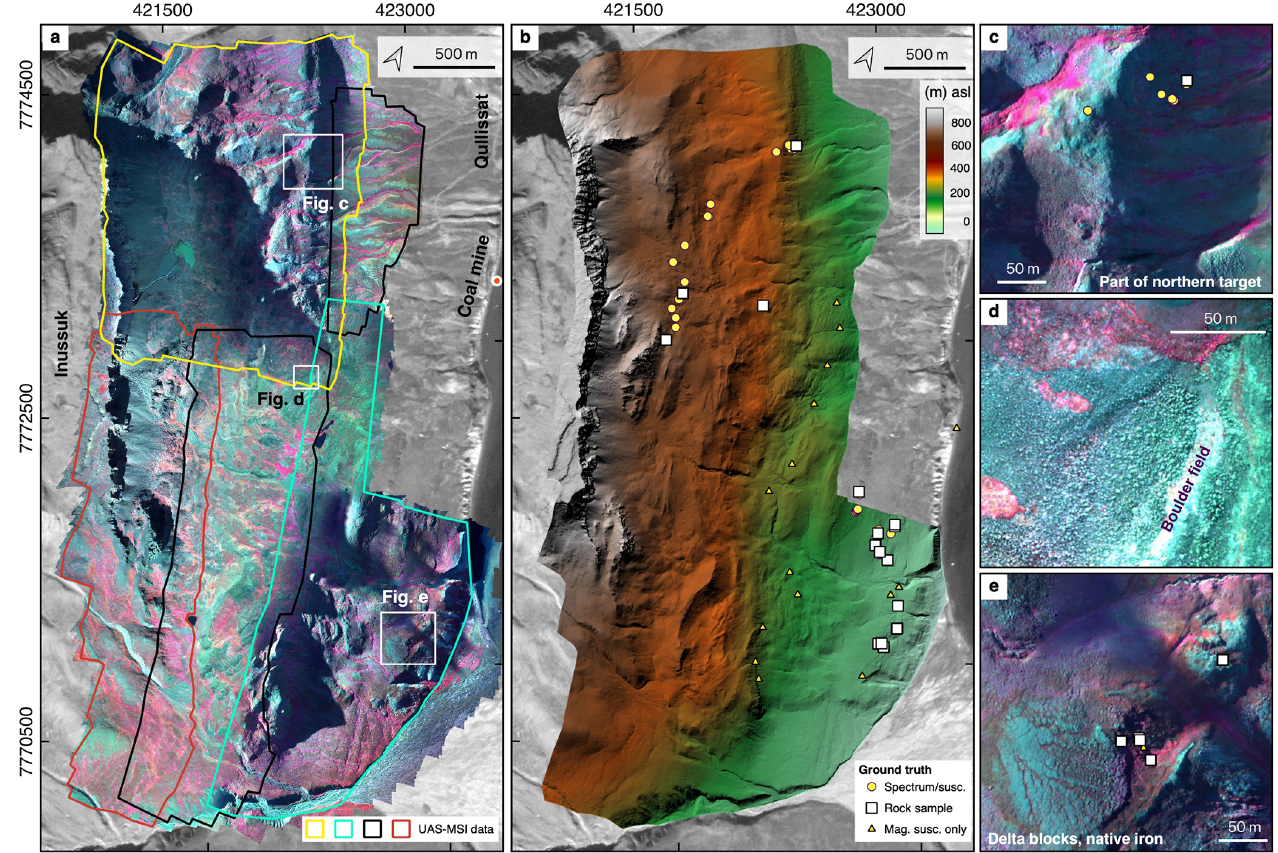
Figure 2. Primary data of the multispectral UAS-based surveys after basic processing. (a) Multispectral mosaic at ∼ 20cm GSD in false colour RGB bands 3, 2, 1. The different polygons outline the survey areas of individual flights. (b) DSM at ∼ 36cm GSD. Locations of collected ground truth data are indicated with symbols. Inset maps enhance view resolution of areas that were ground-sampled during the study, such as (c) an outcrop associated with the northern part of the target magmatic (d) , the central boulder field (e) and outcropping slid volcanic rocks in the southern